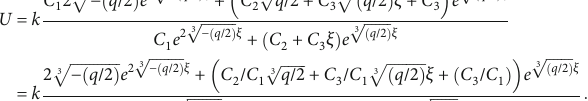
Figure 1: 3D plot of solution (27) for various values of α = β ,